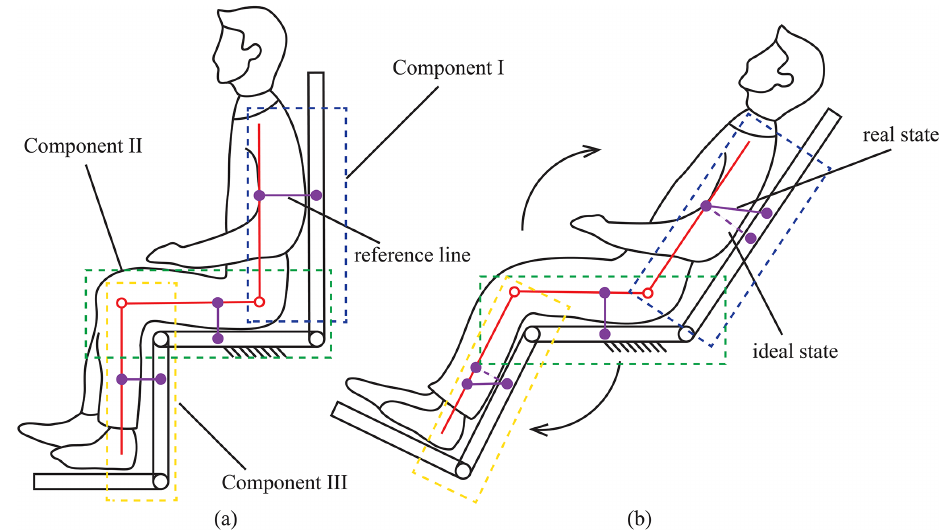
Figure 1. Human–wheelchair coupling model. (a) Human–wheelchair coupling model in the sitting posture. (b) Human–wheelchair coupling model in the sit-to-lie posture.